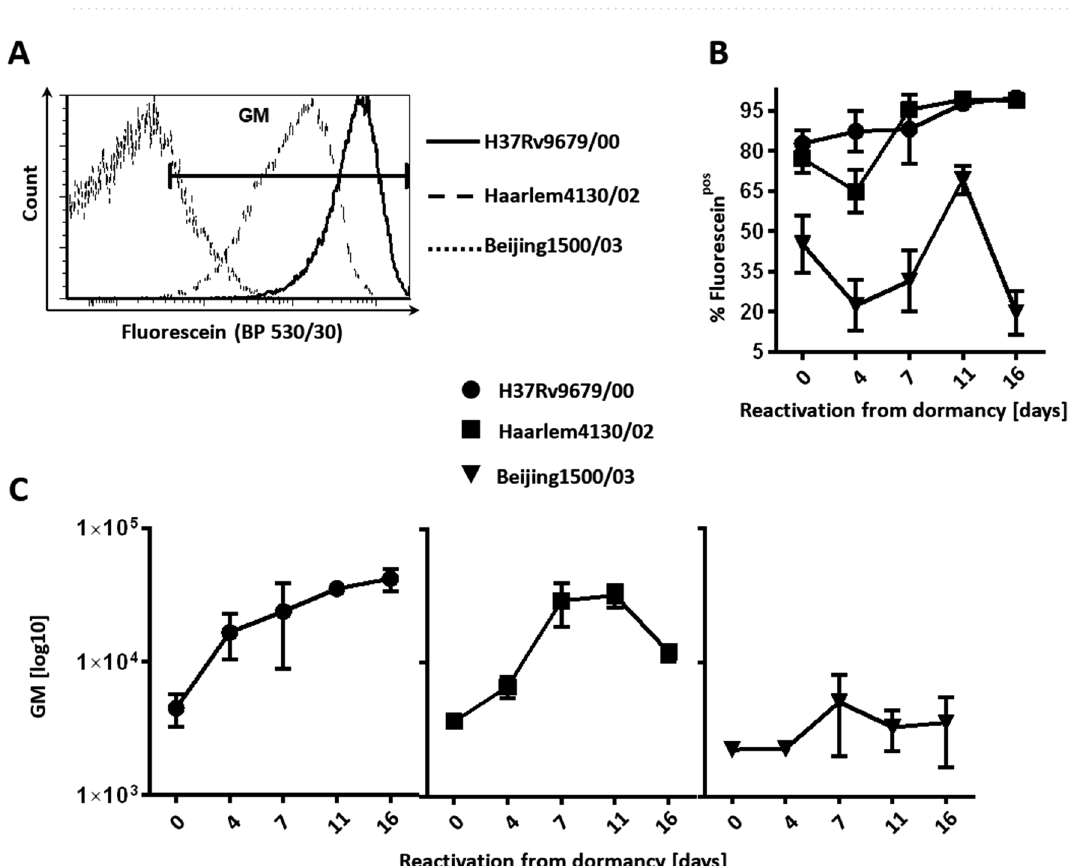
Figure 4. H37Rv (L4) and Haarlem (L4), but not Beijing (L2) recovered metabolic activity after reactivation from dormancy. Anaerobic mycobacterial strains from d35 of hypoxia-induced dormancy were inoculated in fresh medium and incubated in aerated conditions at 37 °C with FDA for 20 min. Example of a histogram of fluorescein-positive mycobacteria at d16 after reactivation after incubation at 37 °C with FDA for 20 min ( A ). Per cent of fluorescein-positive cells ( B ) and geometric mean (GM) fluorescence intensity ( C ) of mycobacterial strains within gate GM were measured at indicated time points. One representative experiment (triplicates) out of two is